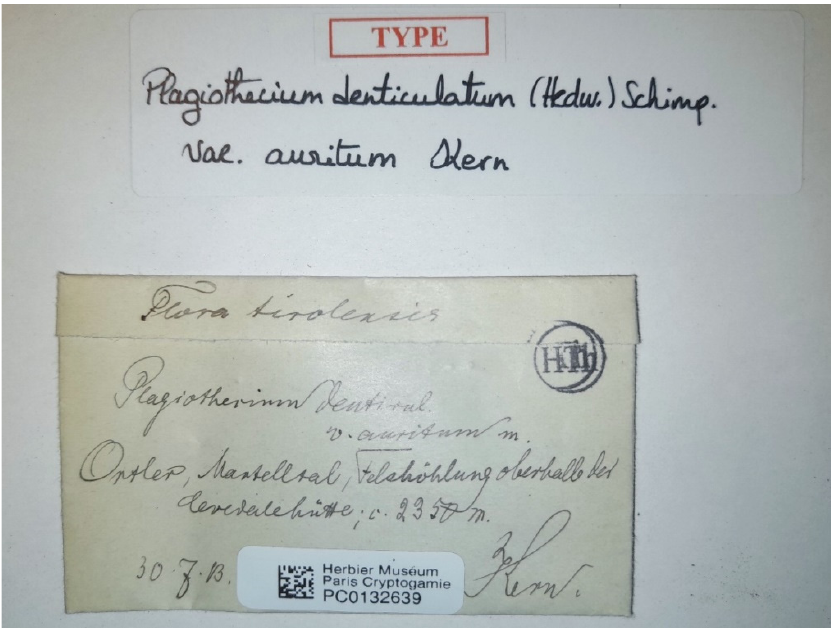
Plants 2022 , 11 , x FOR PEER REVIEW Figure 12. Type of P. denticulatum var. auritum (PC0132639), photo by G.J. Wolski, Paris, November 2021.